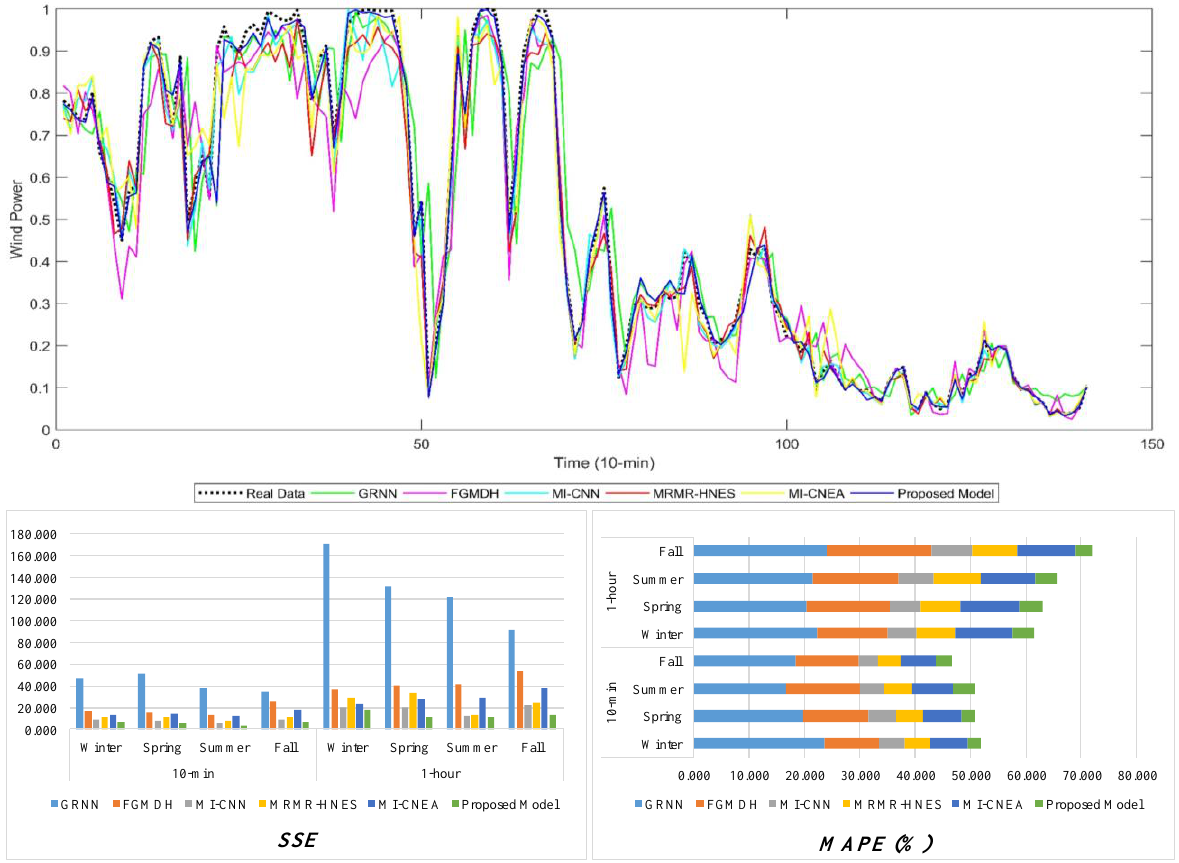
Figure 7. The wind turbine power forecasting results of the comparative models for WT1.